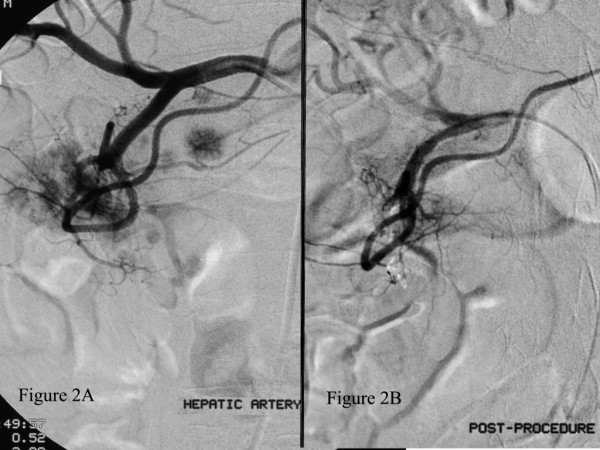
Coeliac angiogram. Figure 2A is an angiogram of the coeliac trunk. This demonstrates a highly vascular mass around the duodenum and pancreas and its blood supply from the pancreaticoduodenal arteries. Numerous other small vascular blushes are seen which represent further pancreatic metastases. Figure 2B is taken post- embolisation and demonstrates successful occlusion of the tumour's blood supply.